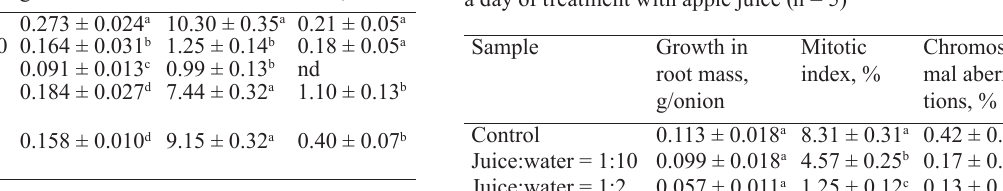
Table 3 Root mass growth, mitotic activity, and the frequency of chromosomal aberrations of onion root meristem cells after a day of treatment with apple juice (n =